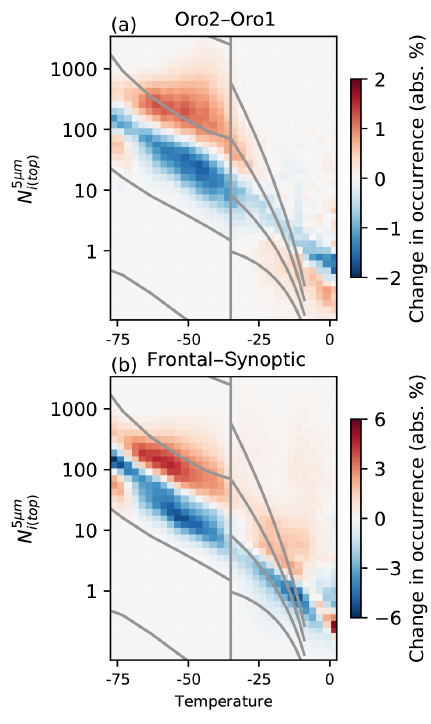
Figure 3. (a) The difference in the N 5µm as a function of tempera- i ( top ) ture between the Oro 2 and Oro 1 regimes (highest and second high- est sextiles of estimated in-cloud updraft, respectively). Red above blue at a given temperature indicates an increased N 5µm in the i ( top ) Oro 2 regimes compared to Oro 1. (b) The difference between the frontal and synoptic regimes. Note the different color scale from (a)